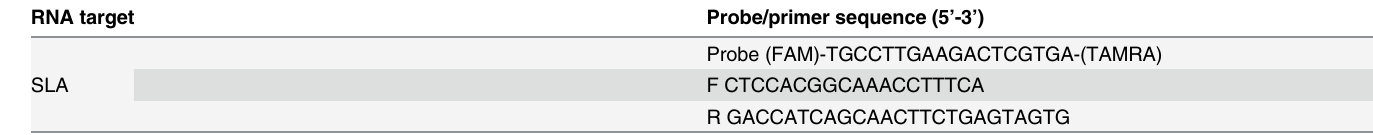
Table 3. Real-time qRT-PCR cytokine mRNA expression levels following CAV infection in different lymphoid tissues. Thymus